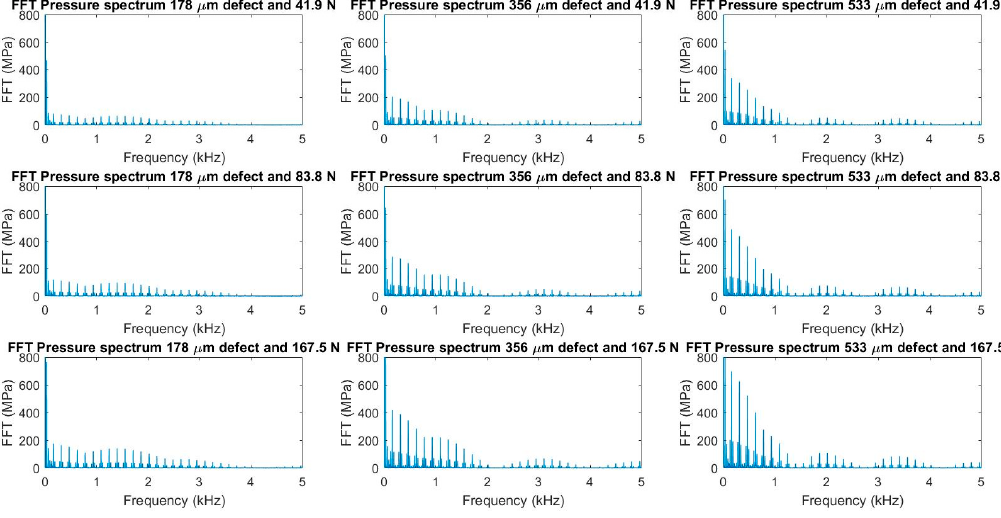
Figure 6. FFT raw spectra: pressure signals.